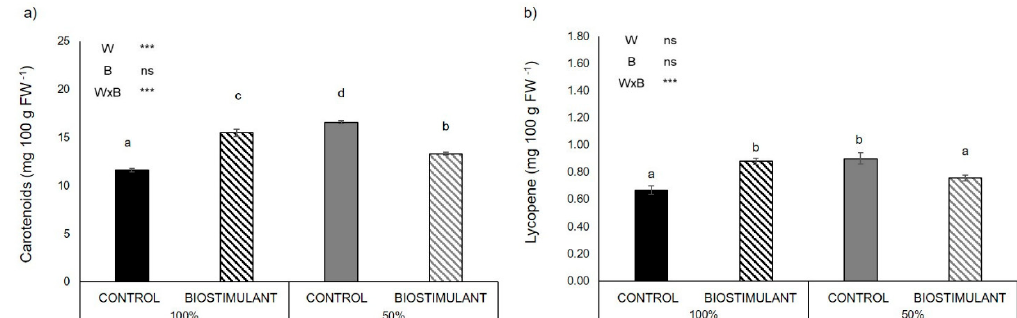
Figure 4. Content of ( a ) carotenoids and ( b ) lycopene in fruit of the tomato genotype ‘E42’ grown in open field in Battipaglia under optimal (100% irrigation) and limited water availability (50% irrigation) and treated (biostimulant) or not (control) with the biostimulant. Values are mean ± SE. Asterisks indicate significant effect of limited water availability (W), biostimulant treatment (B) and their interaction (W × B) according to ANOVA (ns = not significant; * = p < 0.05; ** = p < 0.01; *** = p < 0.001). Different letters indicate significant differences based on Duncan’s test ( p ≤ 0.05).